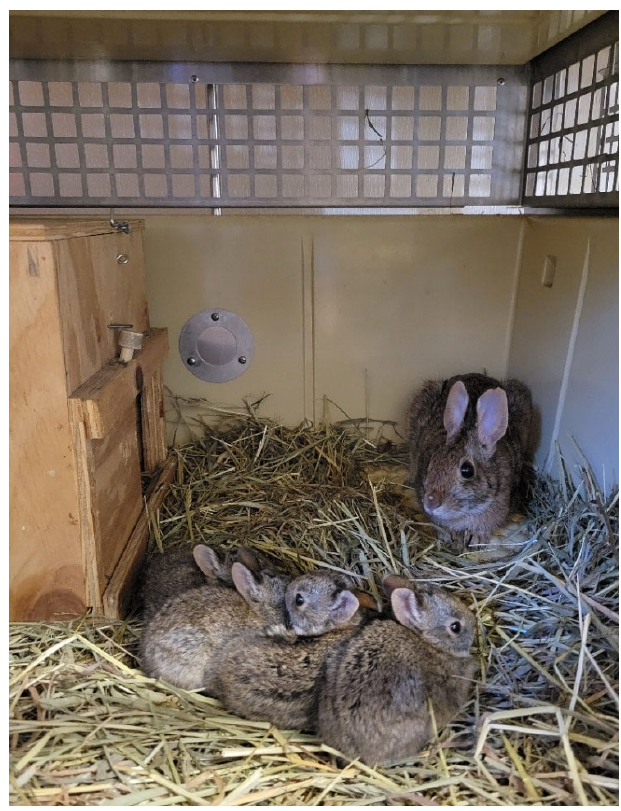
Figure 4. A dam with her 15 ‐ day old kits. The kits will remain with the dam for another 8 days before weaning.